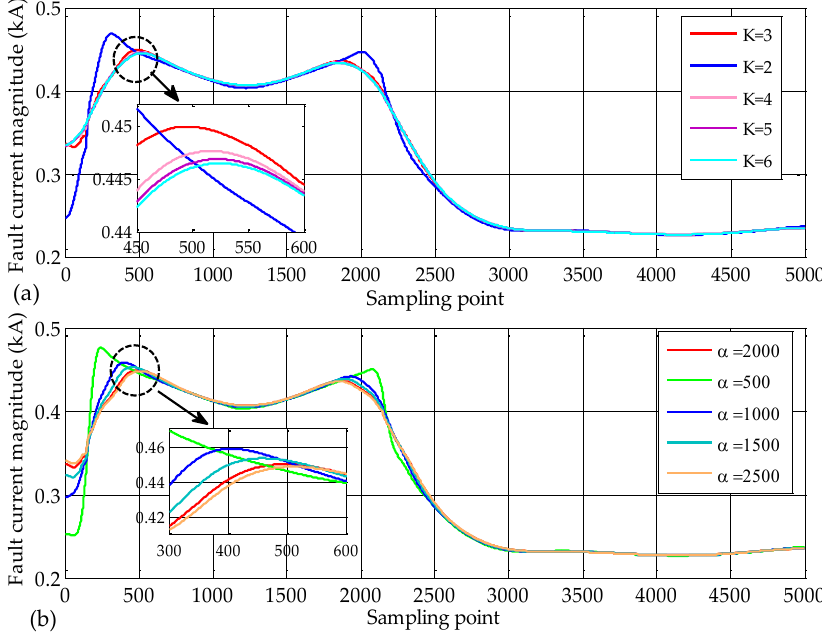
Figure 8. The effect on the mode 1 component due to different K and α : ( a ) α = 2000 and K = 2–6 and ( b ) K = 3 and α = 500–2500.